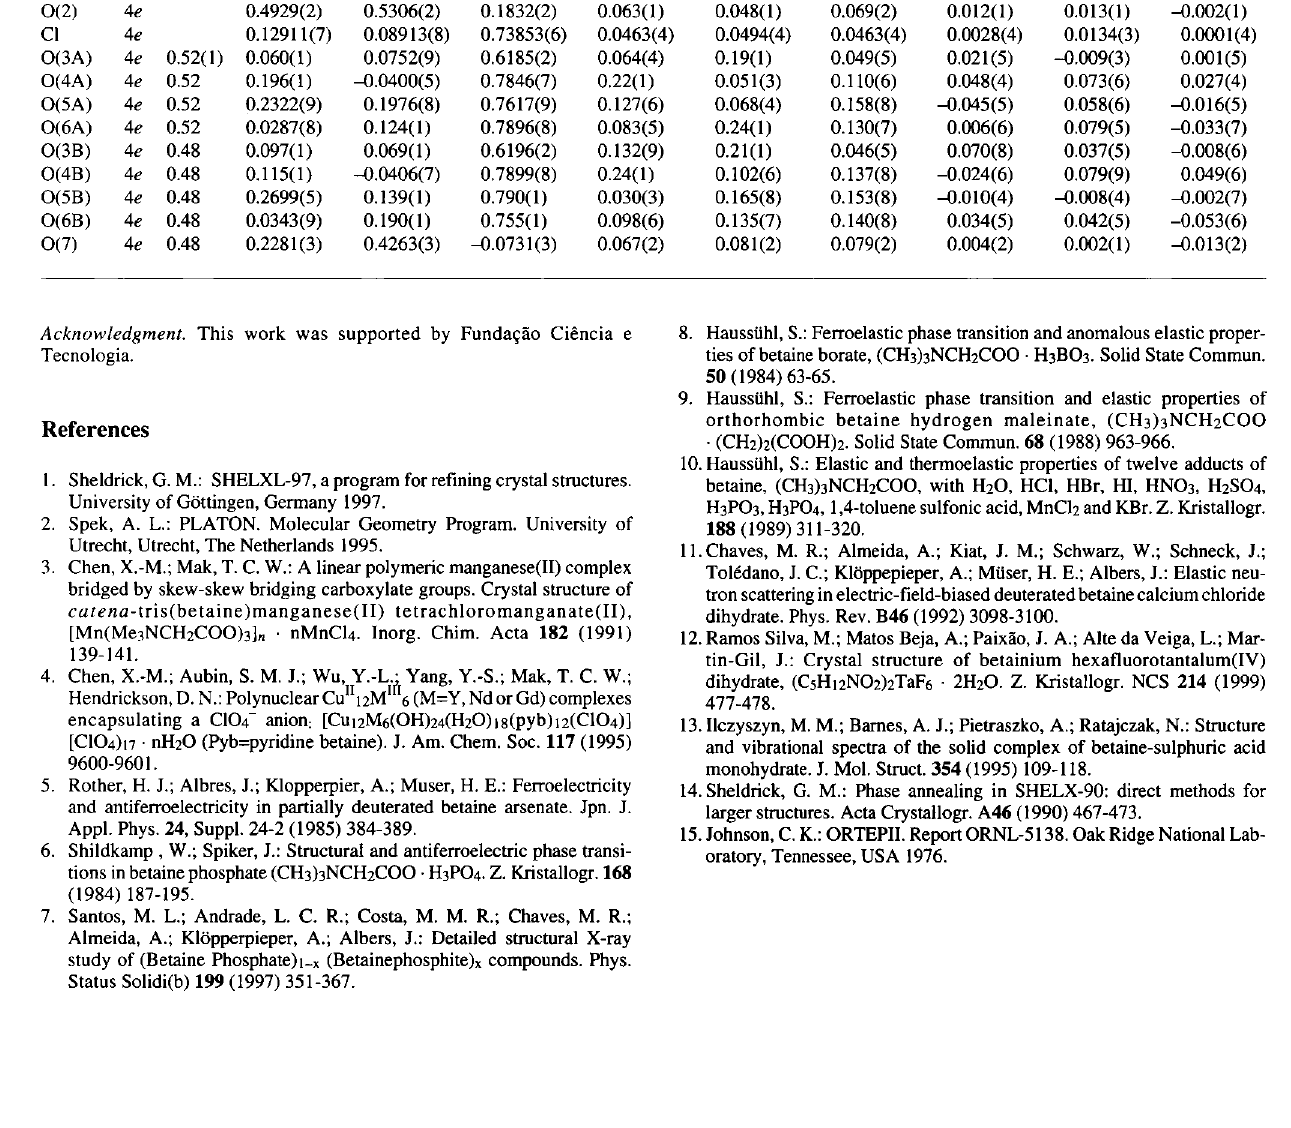
Table 3. Atomic coordinates and displacement parameters (in Â 2